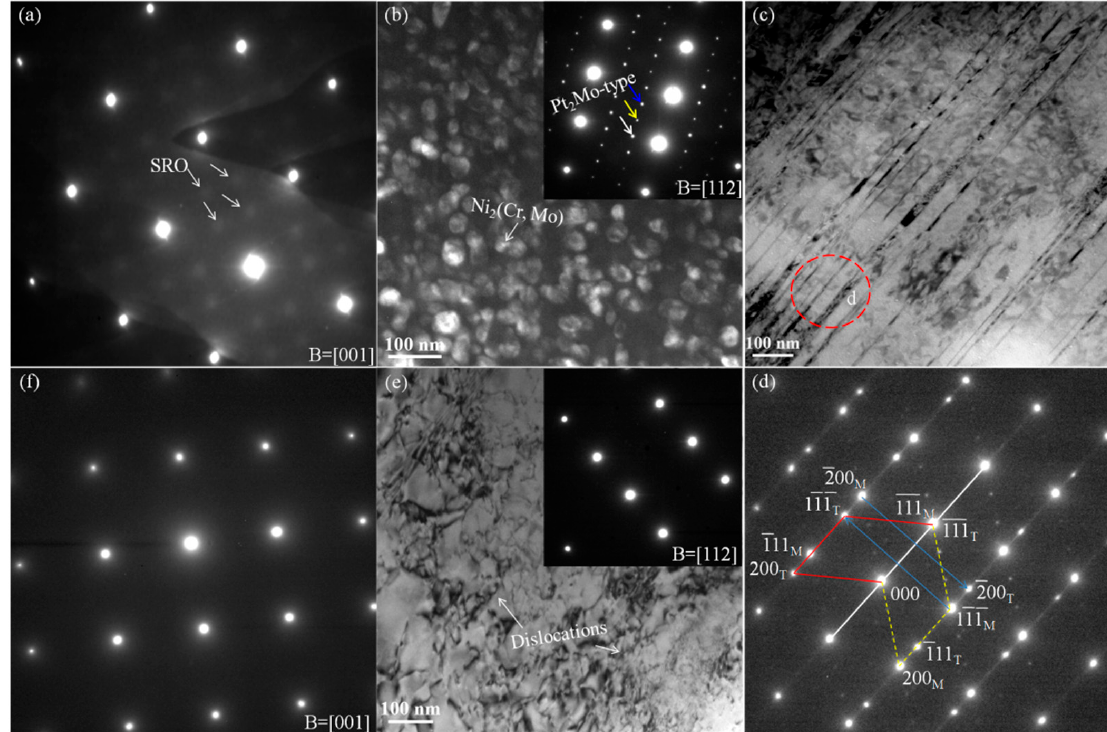
Figure 8. Effect of deformation on the microstructure of C2000 alloy: ( a ) SAED pattern along [001] matrix of quenched sample; ( b ) DF image of sample after quenching followed by aging, and the inset showing SAED pattern along [112] matrix ; ( c ) BF image of the aged sample during deformation; ( d ) SAED pattern taken from regions indicated by dotted circles in ( c ); ( e ) BF image sample after quenching followed by cold rolling of 50%, and the inset showing SAED along [112] matrix ; and ( f ) SAED pattern along [001] matrix after quenching, cold rolling of 50%, and aging. After a short annealing of 15 min, as shown in Figure 9a, the orientation of the not recrystallized grains is preferred, among which the green color with <001> is